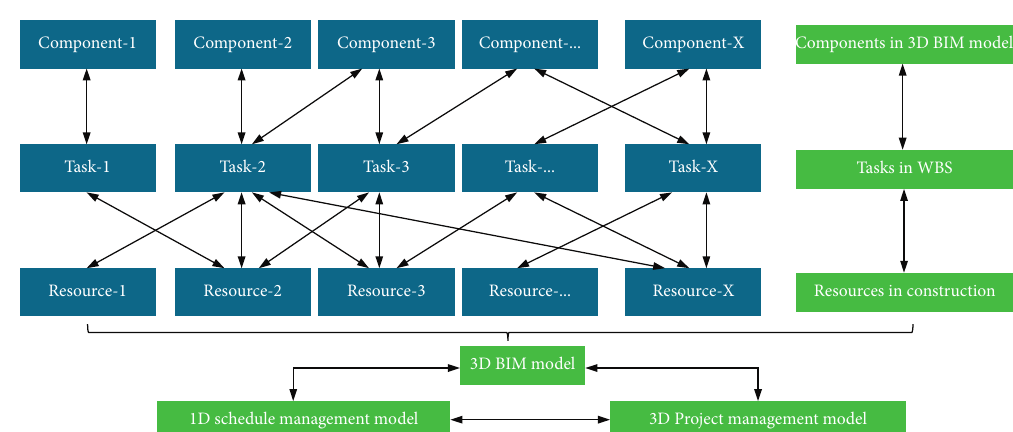
Figure 3: A typical logical relationship in